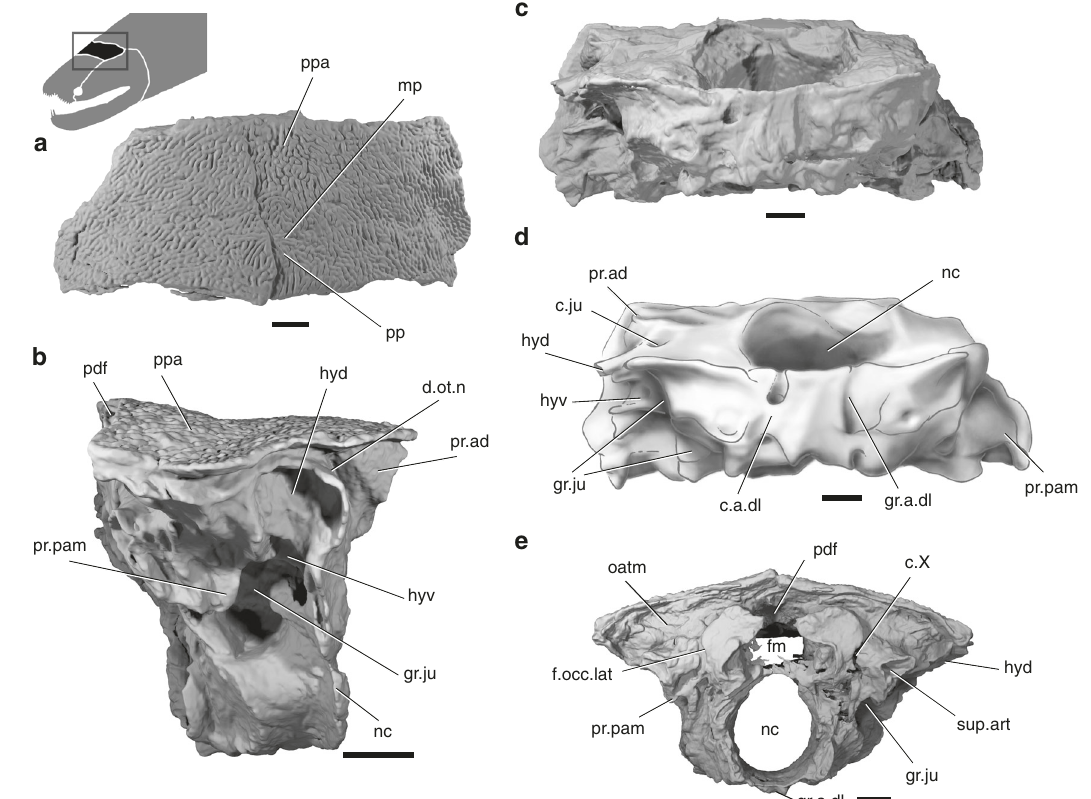
Fig. 1 The skull of Ptyctolepis brachynotus gen. et sp. nov. (IVPP V23386). High-resolution CT rendering of specimen in dorsal ( a ), right lateral ( b ), ventral ( c ), and posterior ( e ) views and ( d ) interpretive drawing in ventral view. c.a.dl canal for lateral dorsal aorta, c.X canal for vagus nerve, d.ot.n dorsal branch of the otic lateral line nerve, fm foramen magnum, f.occ.lat lateral occipital fi ssure, gr.a.dl groove for lateral dorsal aorta, gr.ju groove for jugular canal, hyd dorsal hyoid articular area, hyv ventral hyoid articular area, mp middle pit-line, nc notochordal canal, oatm attachment area for trunk musculature, pdf posterior dorsal fontanel, pp posterior pit-line, ppa postparietal, pr.ad antero-dorsal process, pr.pam parampullary process, sup.art articular area for suprapharyngobranchial. Scale bar, 5